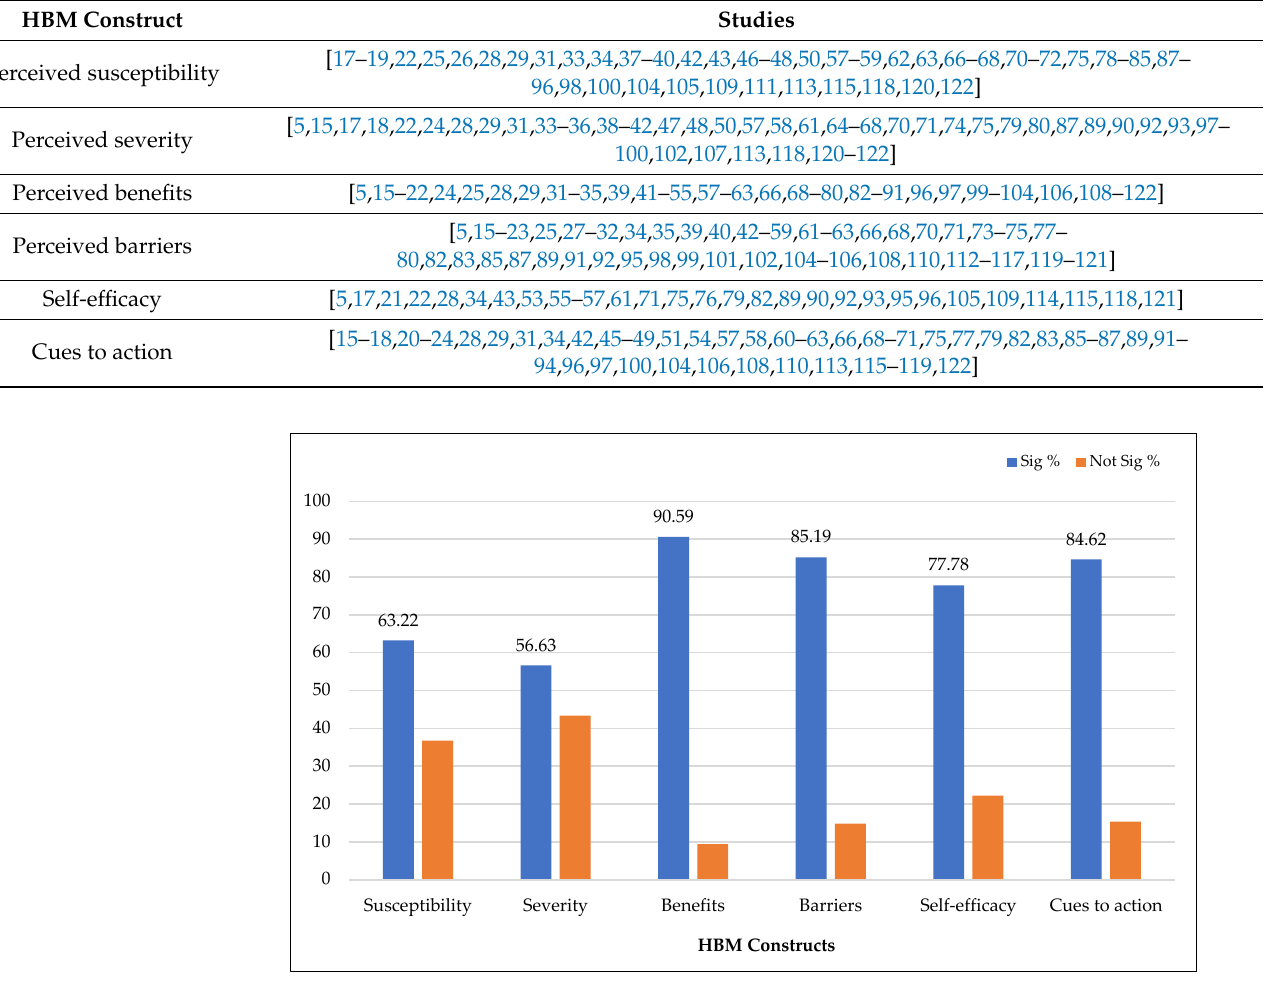
Figure 3. Health belief model constructs predicting primary series vaccination intention.